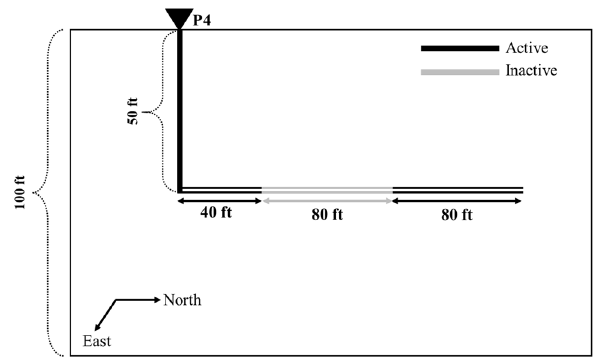
Fig. 21 Schematic view of producer P 4, a multi-segmented horizon- tal well in case V